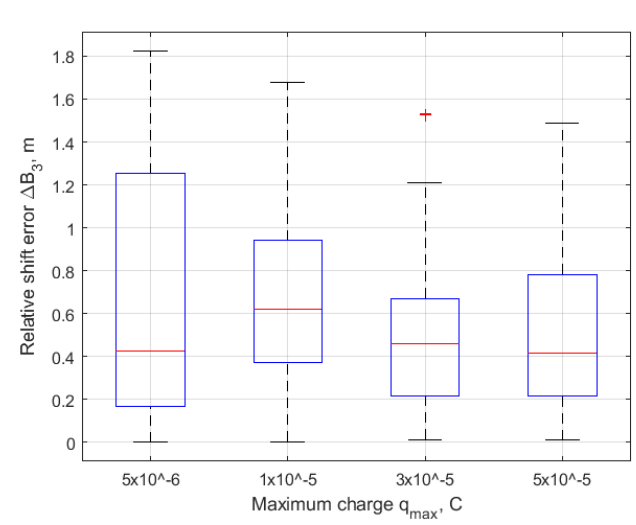
Figure 16. Mean error in